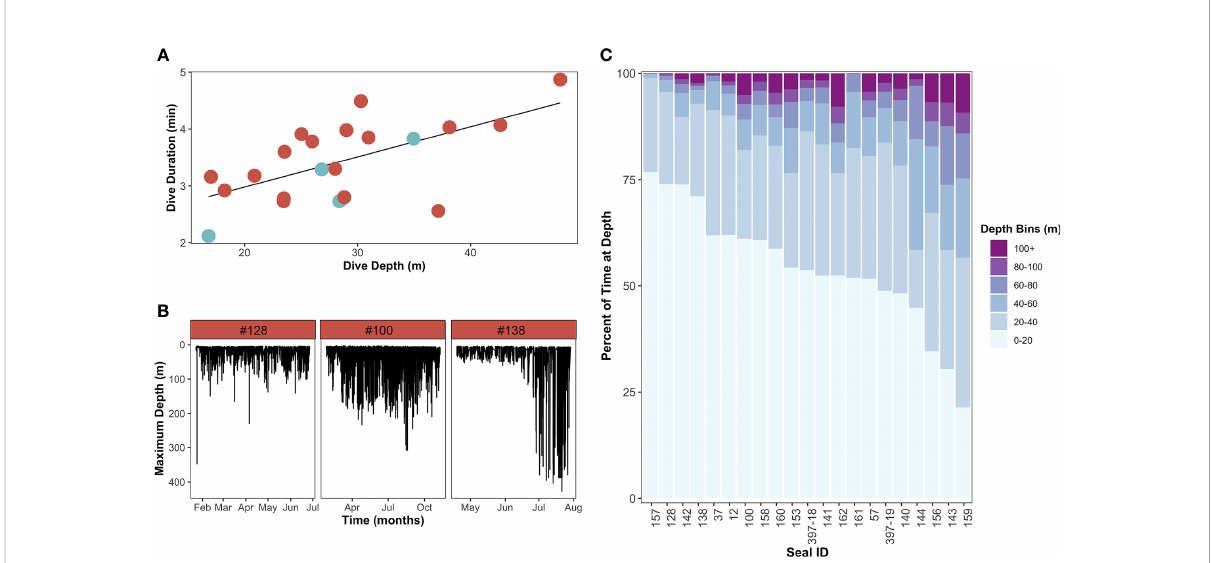
FIGURE 5 Dive behavior of leopard seals instrumented at Cape Shirreff. (A) Linear regression of the relationship between dive depth and dive duration (y=1.9+0.053x, R 2 = 0.62, p=0.003). Each individual is represented by a circle and colored by sex (red-orange circles are females, blue-gray circles are males). (B) Representative dive pro fi les of three representative adult female leopard seals demonstrating variability in dive depth over time, including a shallow diver [left; #128; mean depth: 17 ± 13 m; coef fi cient of variation (CV): 0.79], a deep diver (middle; #100; mean depth: 29 ± 33 m; CV: 1.12), and a seasonally variable diver (right; #138, 24 ± 40 m; CV: 1.71). (C) Histogram demonstrating the percentage of time each seal spent in different depth bins. Depth bins are sorted from deepest (100+ m; top) to shallowest (0-20 m;